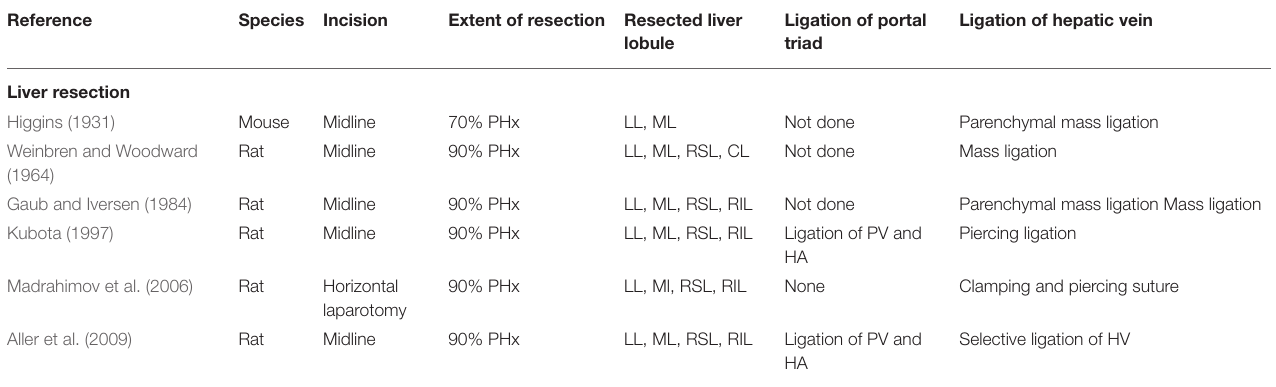
TABLE 1 | Overview of different liver resection techniques, differing in how the vascular structures (portal triad and hepatic vein) are ligated respectively transected. Reference